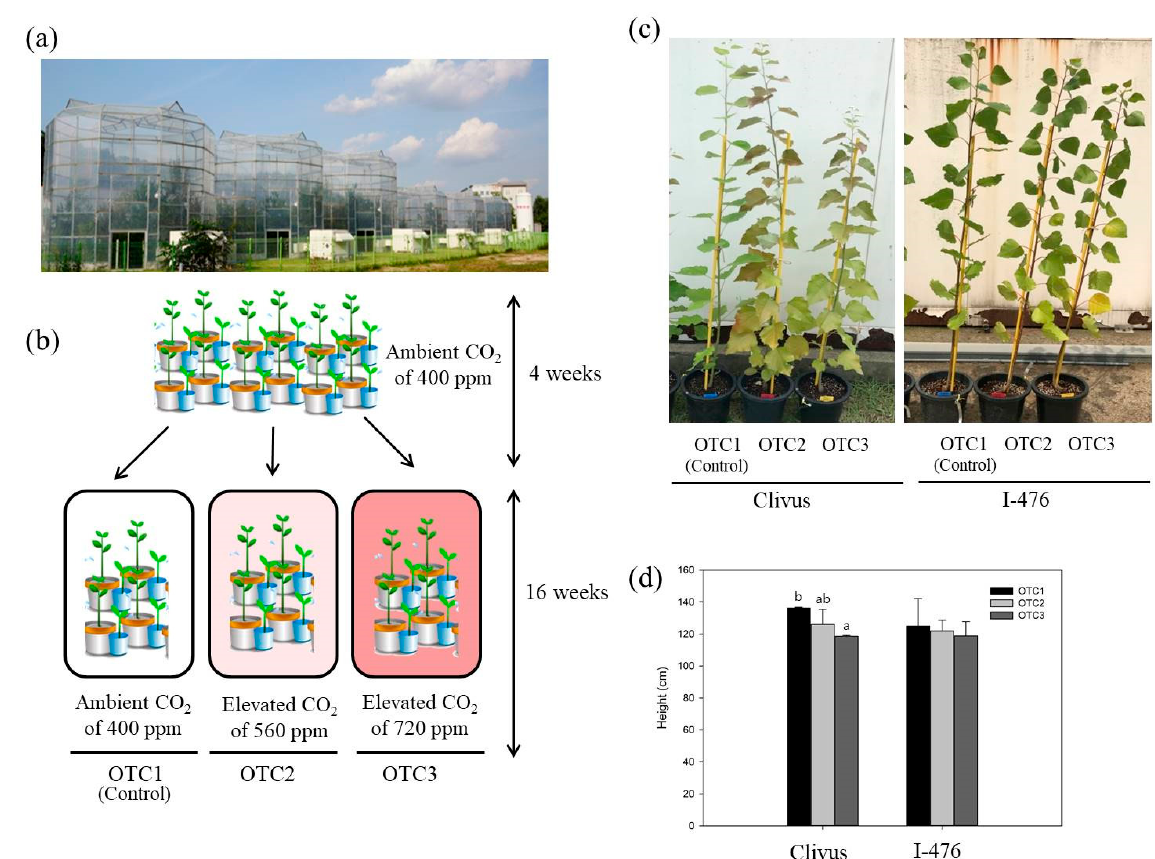
Figure 1. A schematic representation of the experimental design and the phenotypes of poplar clones. ( a ) A photograph of the whole open-top chambers (OTCs) facility. ( b ) The conceptual model. ( c , d ) The effects of elevated CO 2 on the shoot growth of the poplar Clivus and I-476 clones. The values are the means ± SDs ( n = 10) Different lowercase letters indicate significant differences (Tukey’s HSD, p < 0.05 for ( d )).